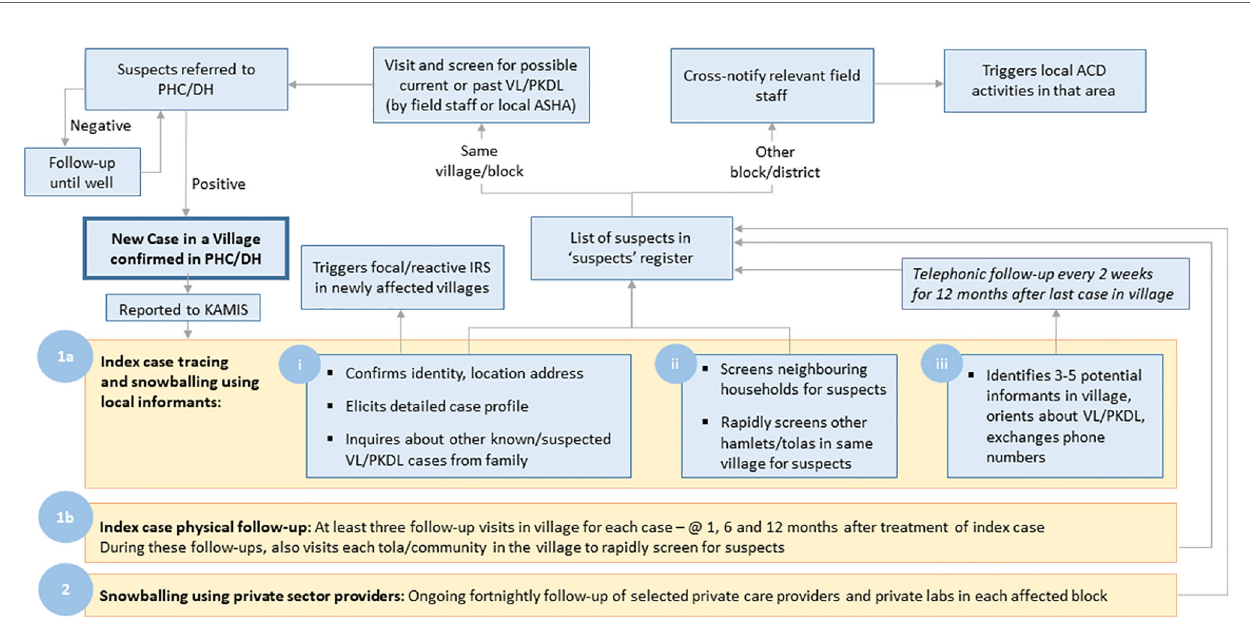
FIGURE 2 | Schematic of the steps involved in active case detection linked to the Kala-azar Management Information System (KAMIS). Active case searches are triggered by the report of a new con fi rmed visceral leishmaniasis case. Searches employ snowballing based on information from the index case and knowledgeable local informants regarding other nearby case, periodic follow-up of the index case, and repeated contacts over time with local private health care